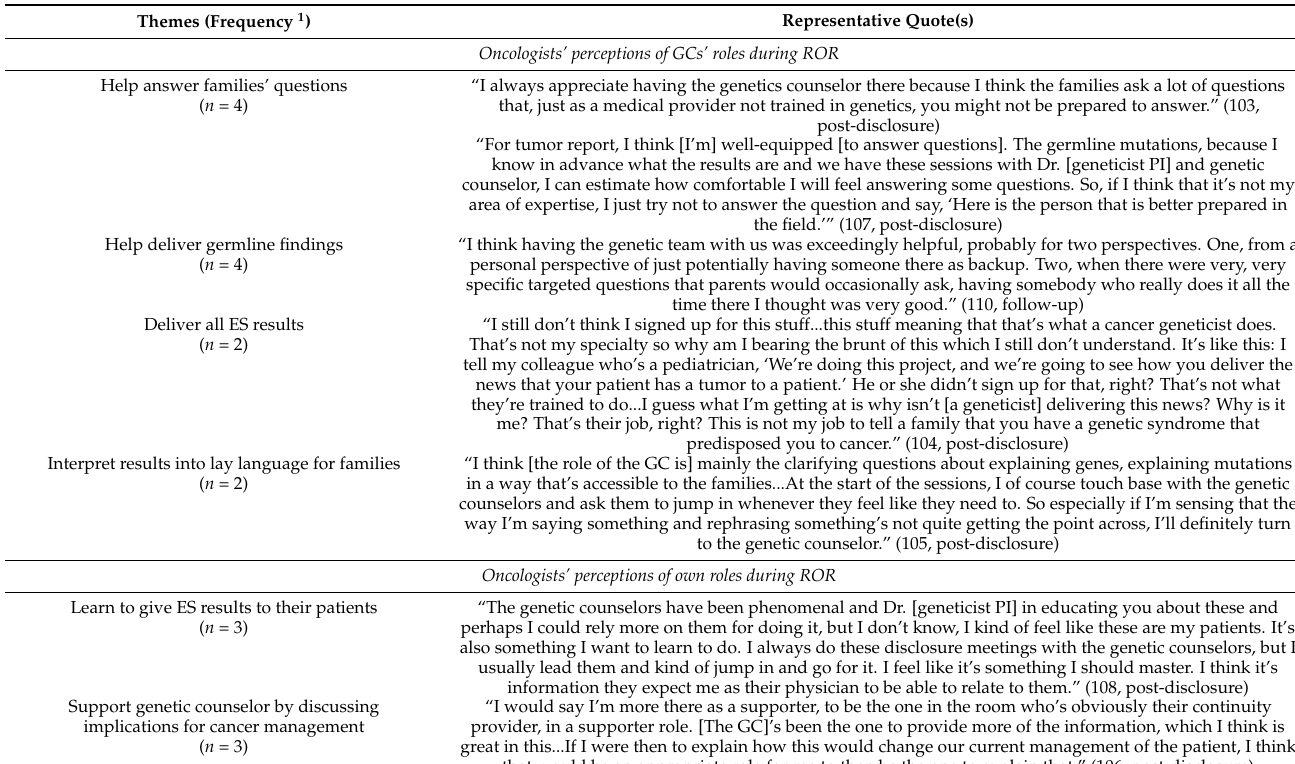
Table 1. Oncologists’ perceptions of genetic counselors’ roles and own roles during return of results sessions. Themes (Frequency 1